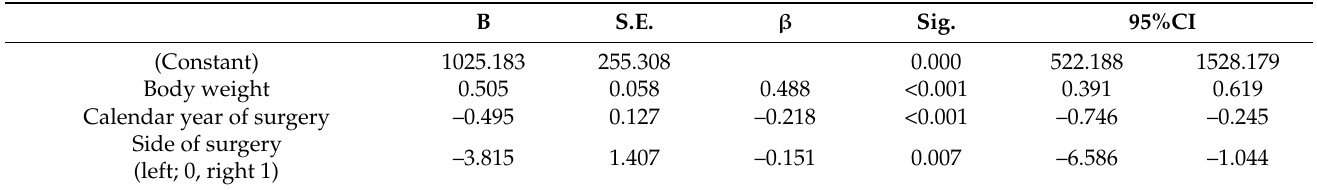
Figure 1. Comparison of the operative times for the left and right sides in total knee arthroplasty (TKA) ( p = 0.015). Table 2. Results of the multiple regression analysis using a stepwise variable selection method.